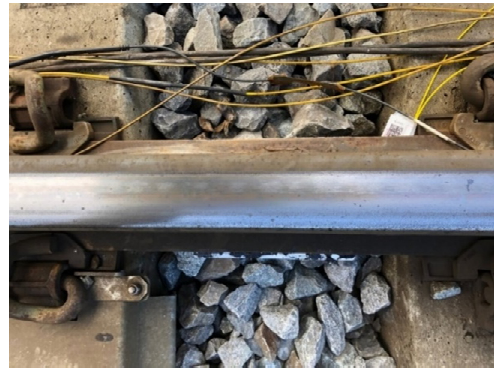
Figure 7 . Picture of the setup: pad installed under the rail. Figure 7. Picture of the setup: pad installed under the rail.